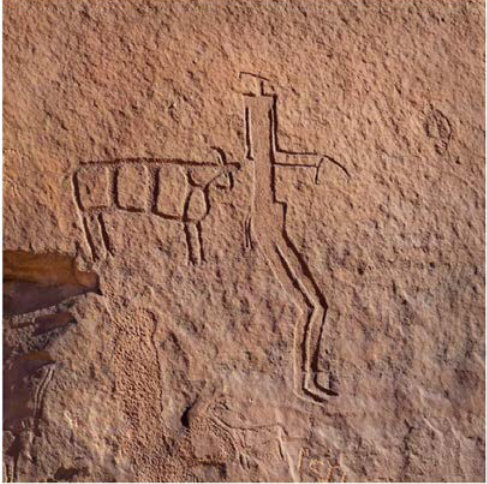
Figure 1. Human form holding what looks like a boomerang from Jubbah, followed by what looks like a bovid, located at Jubbah, Northern Arabia.